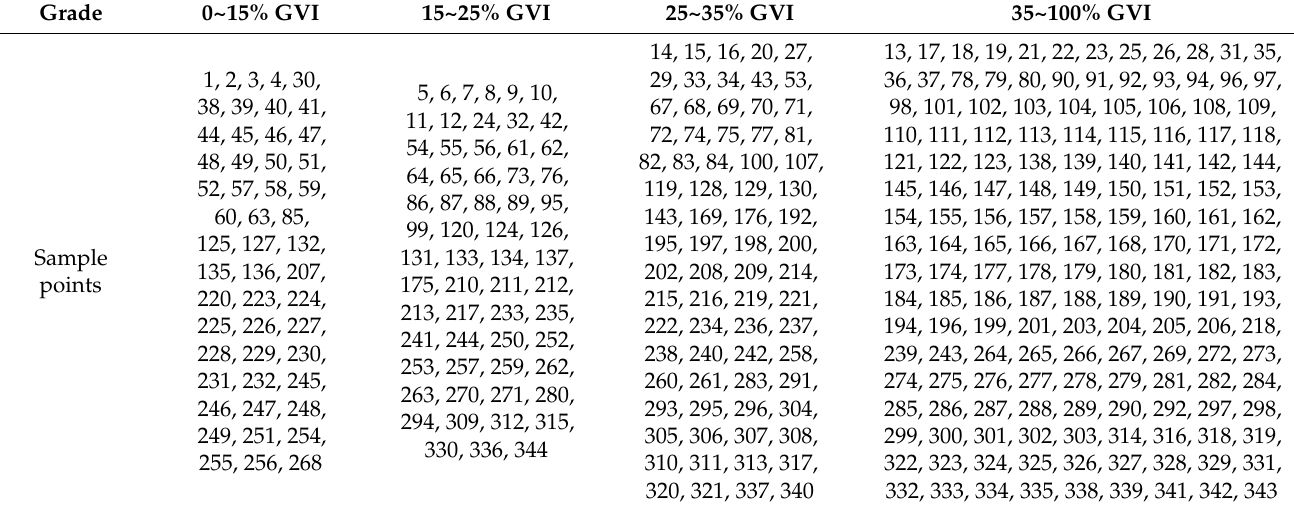
Table 1. The GVI grades of sample